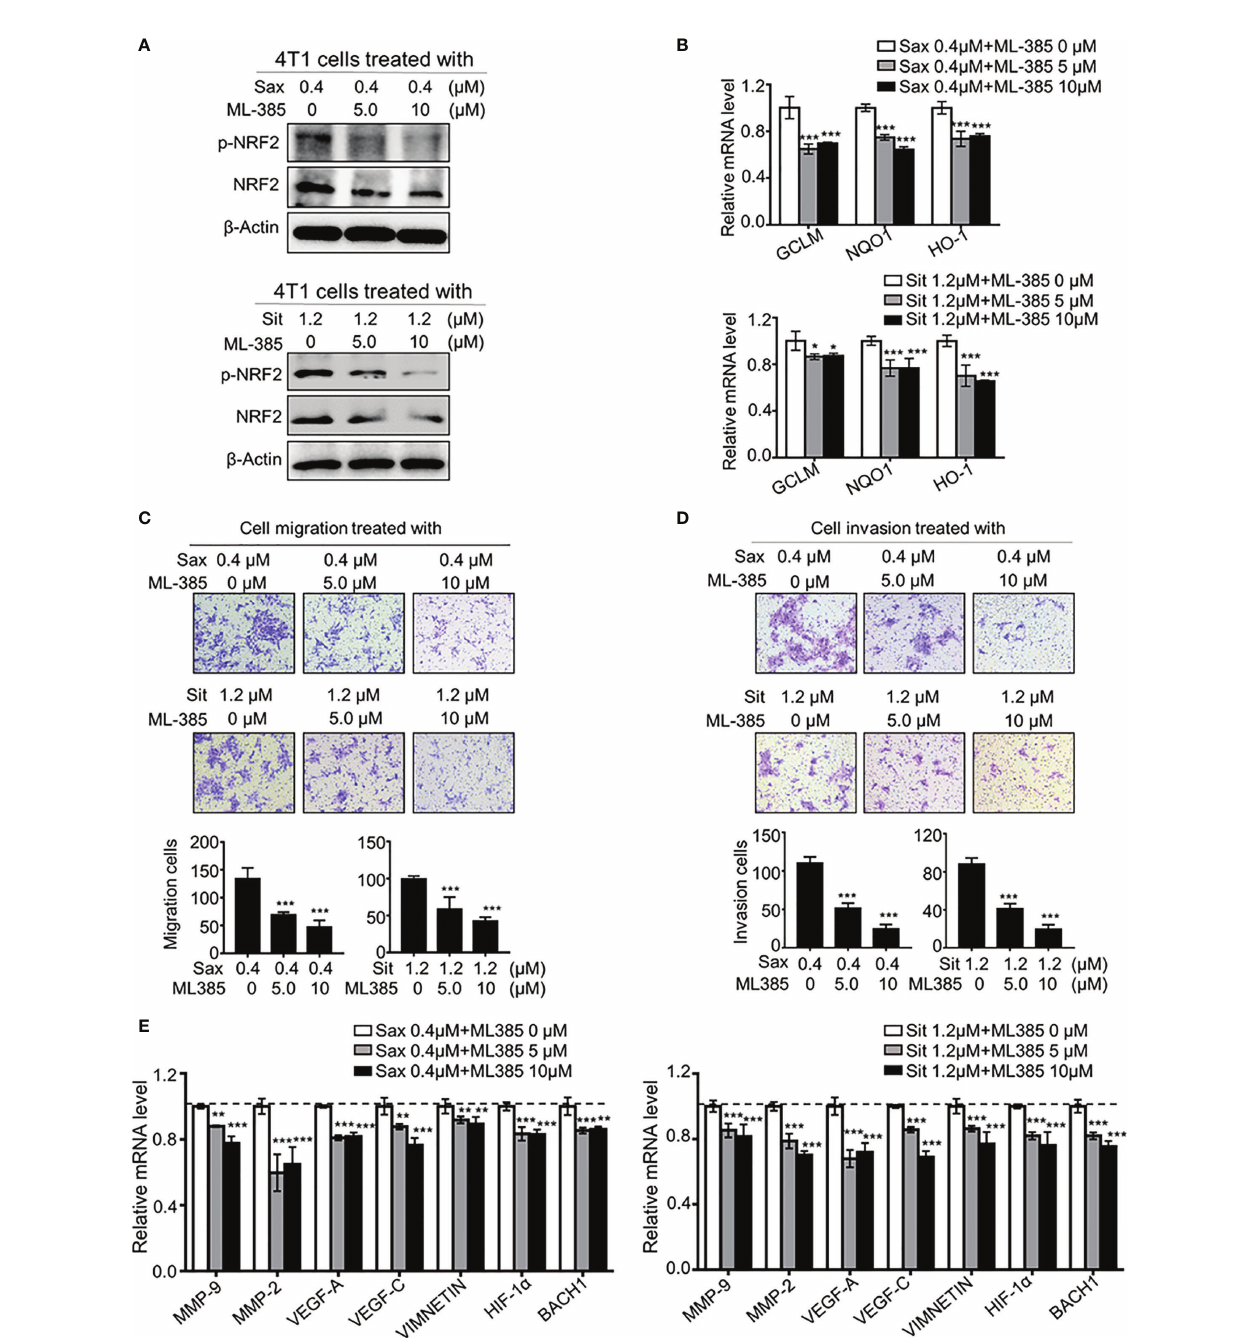
FIGURE 4 | Blockage NRF2 reverses DPP-4i-driven metastasis in vitro (A, B) NRF2 inhibition reverses DPP-4i-driven NRF2 activation. 4T1 cells were co-treated with DPP-4i and NRF2 speci fi c inhibitor ML-385 for 4h. NRF2 and p-NRF2 expressions were detected by Western blotting (A) and NRF2-responsive genes levels were detected by qRT-PCR (B) . b -actin gene was as an internal control. (C, D) NRF2 blockage attenuates DPP-4i – driven cell migration and invasion in vitro . 4T1 cells were subject to cell migration (C) and cell invasion (D) upon co-treatment with DPP-4i and ML-385 for 24 h. Migration or invasion cells were counted in 5 to 10 random fi elds. (E) NRF2 blockage abrogates DPP-4i-driven metastasis-associated gene levels. 4T1 cells were co-treated with or without DPP-4i and ML-385 and metastasis-associated gene levels were detected by qRT-PCR. b -actin gene was as an internal control. Data are presented as mean ± SD of three independent experiments. Scale bar: 50 m m. Representative images are shown. *p < 0.05, **p < 0.01, and ***p < 0.001 between the indicated groups determined by one-way analysis of variance